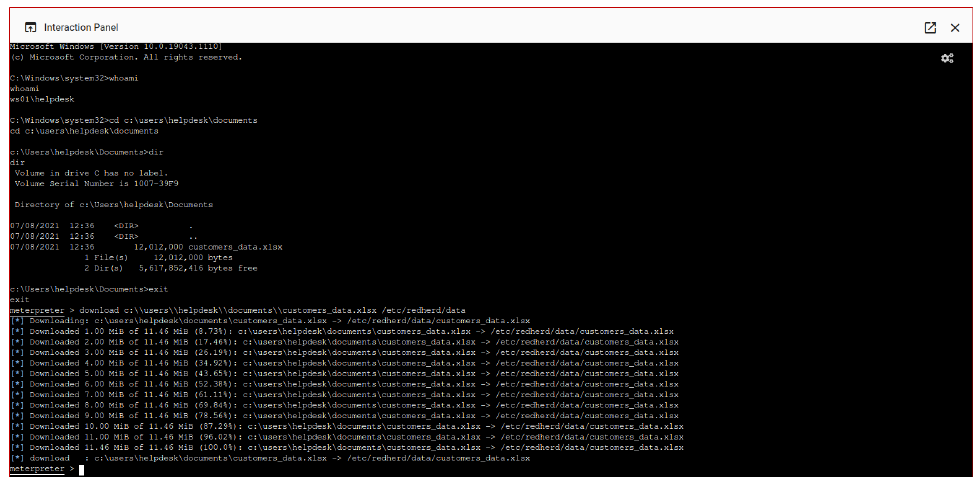
Figure 12. Sensitive file download from the target.